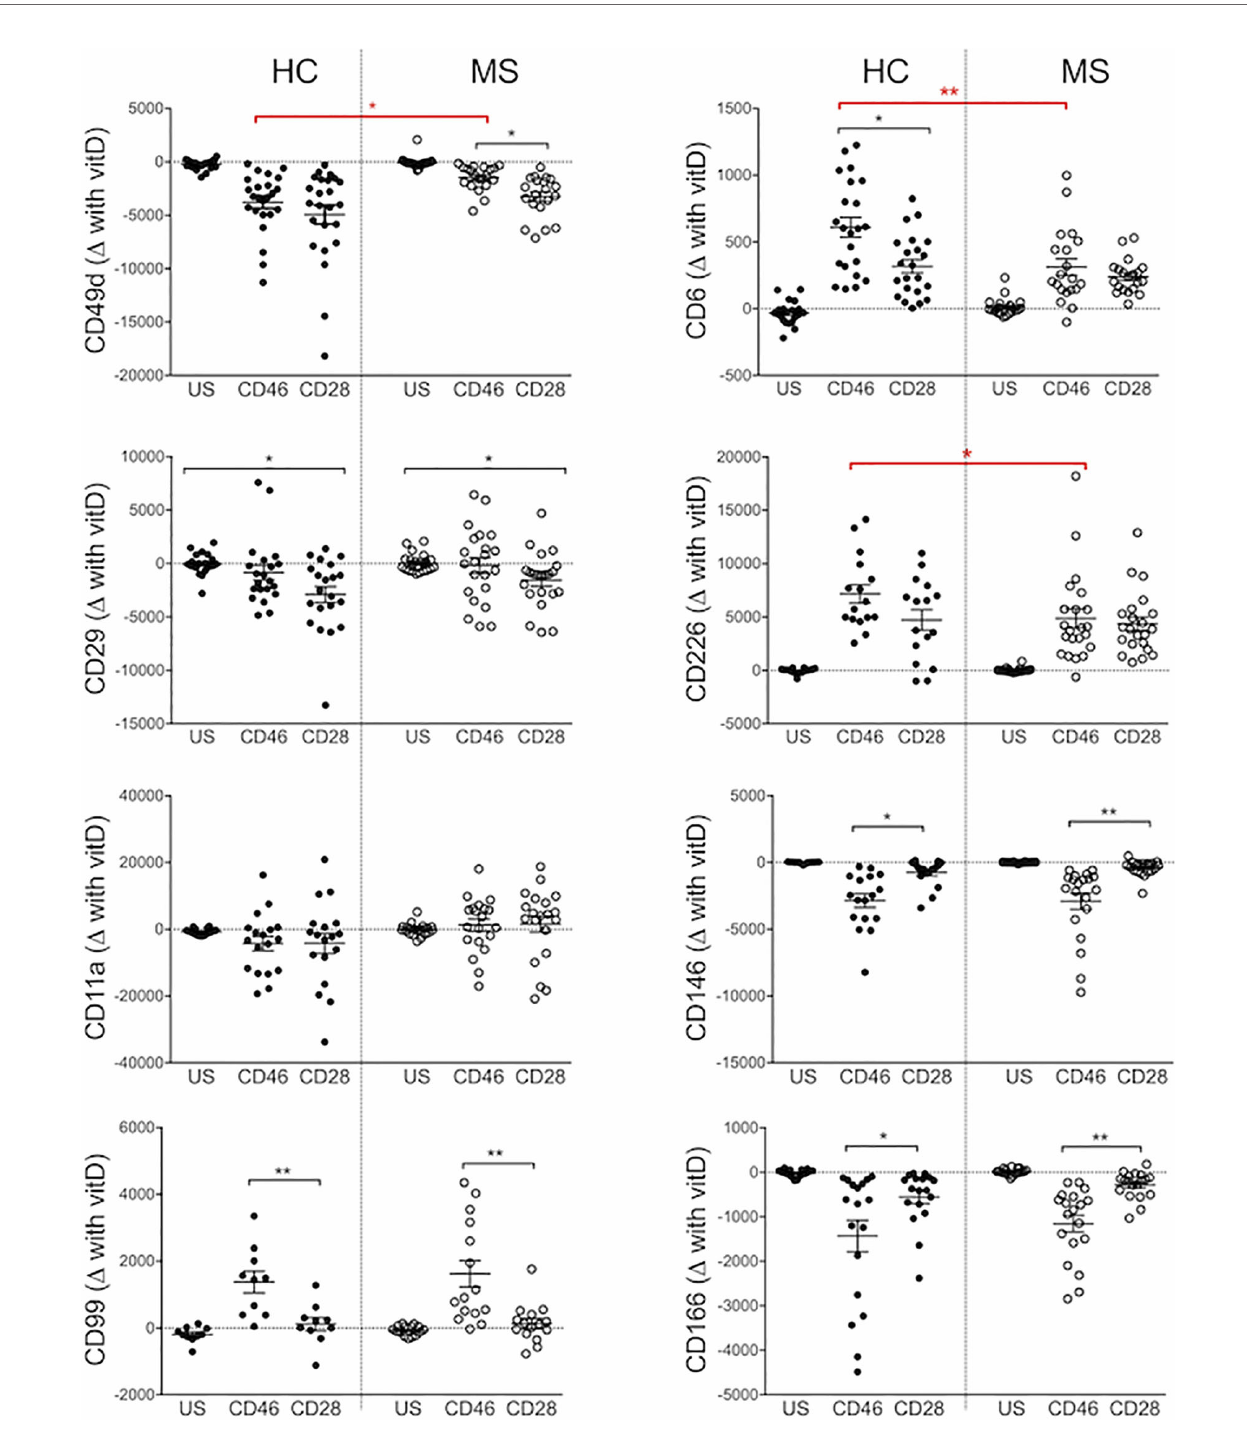
FIGURE 3 | 1,25(OH)2D3 exerts similar effects on the phenotype of activated multiple sclerosis (MS) T cells. CD4+ T cells isolated from the cohort of healthy controls (HC) (shown in Figures 1 and 2 ) or patients with relapsing-remitting stage (RRMS) (n=20) were activated with anti-CD3 and anti-CD28 or anti-CD46 as indicated, in the presence or absence of 1,25(OH)2D3 (VitD). The difference in expression of CD49d, CD29, CD11a, CD99, CD6, CD226, CD146, and CD166 induced by 1,25(OH)2D3 is plotted, Kruskall-Wallis test. *: p<0.05 to 0.01 and **: 0.001 to